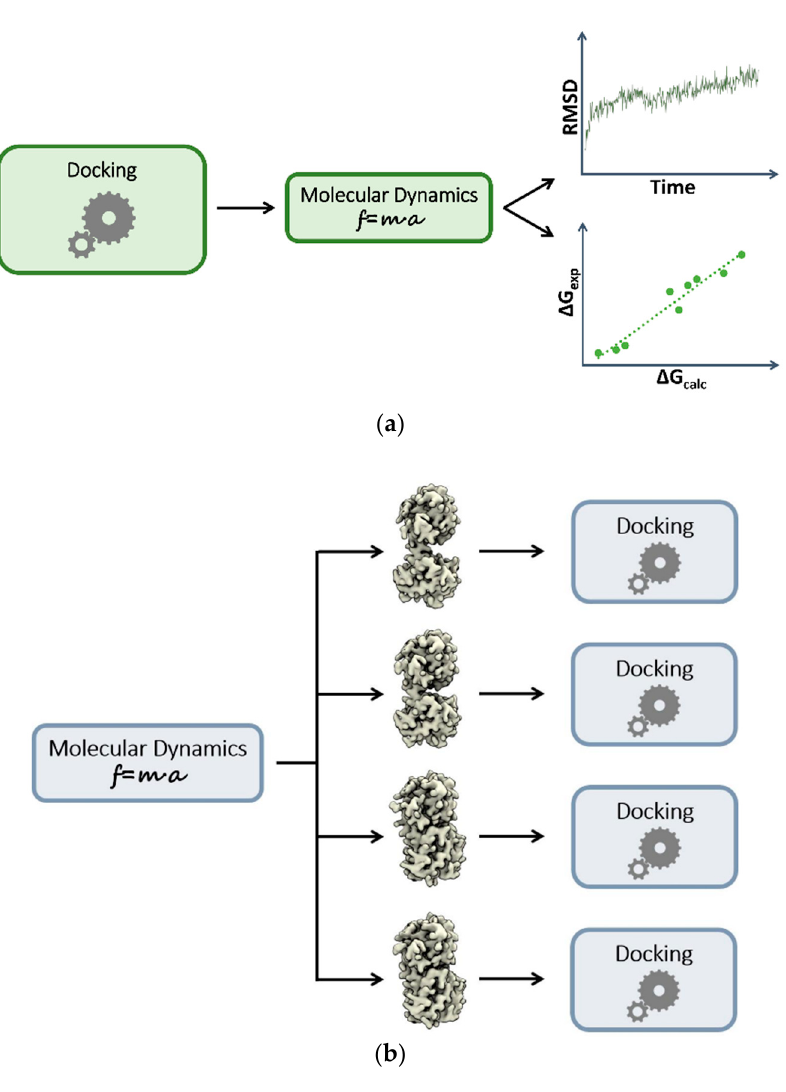
Figure 1. Sequential combination of docking and MD simulations. ( a ) MD employed for rescoring or refining docking poses; ( b ) MD employed for conformational ensemble generation. Docking is then performed against multiple rigid receptor conformations.